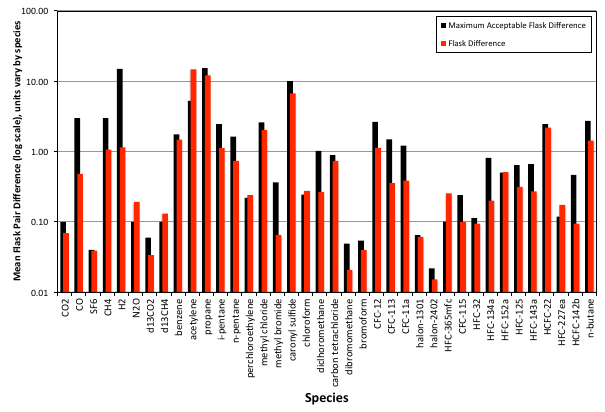
Fig. 6. Difference between predicted and measured flask CO 2 mole fraction, plotted against the CO 2 mole fraction. Predicted mole frac- tions were calculated from in situ ( ∼ 2s) CO 2 measurements. Red points use the full weighting function to calculate the predicted CO 2 mole fraction; blue points use a simple average of the in situ values during the flask sampling time. Error bars on the blue points indi- cate the standard deviation of the in situ measurements during the sampling